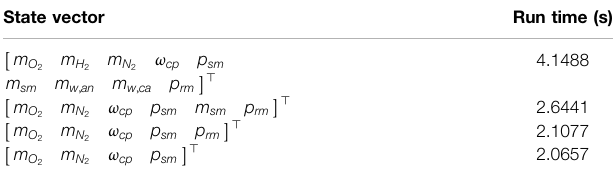
TABLE 2 | FC models state vectors and run time. State vector